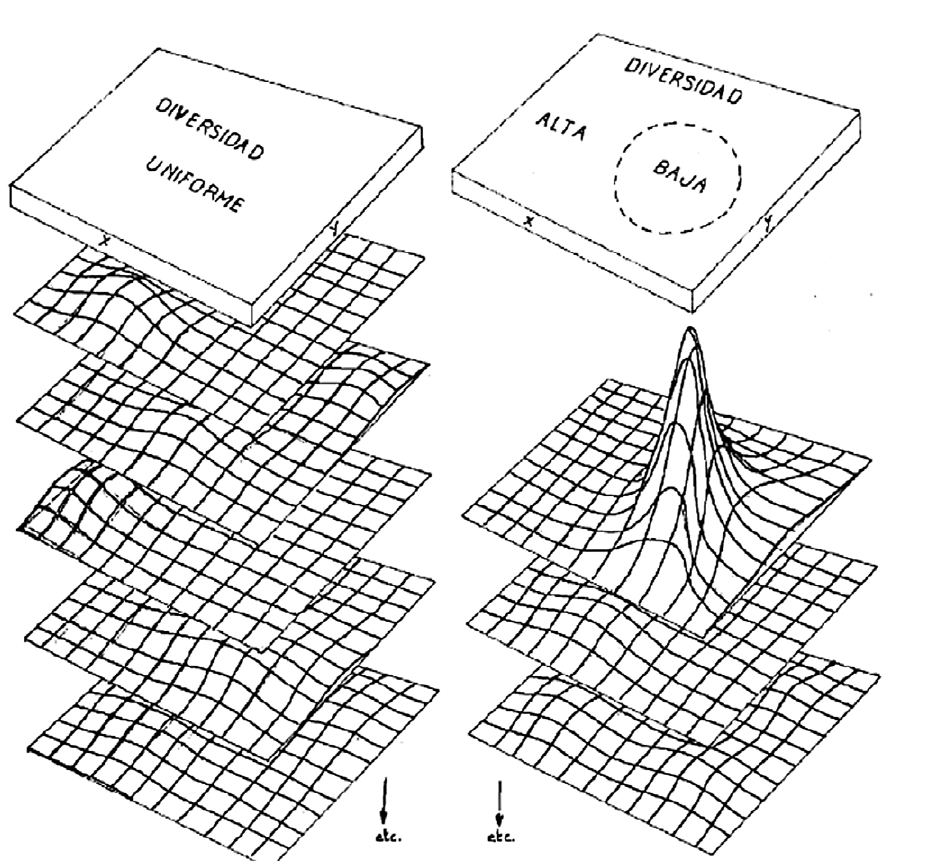
Fig. 3. – Conceptual representation of isotropic (left) and anisotropic (right) phytoplankton distributions. Diversity is uniform (“Diversidad uniforme”) on the left and shows low diversity peaks in a high diversity background (“Diversidad, alta, baja”) on the right. The coordinates x , y , z may refer to a metric or to an ecological space (From Margalef 1963c: Fig